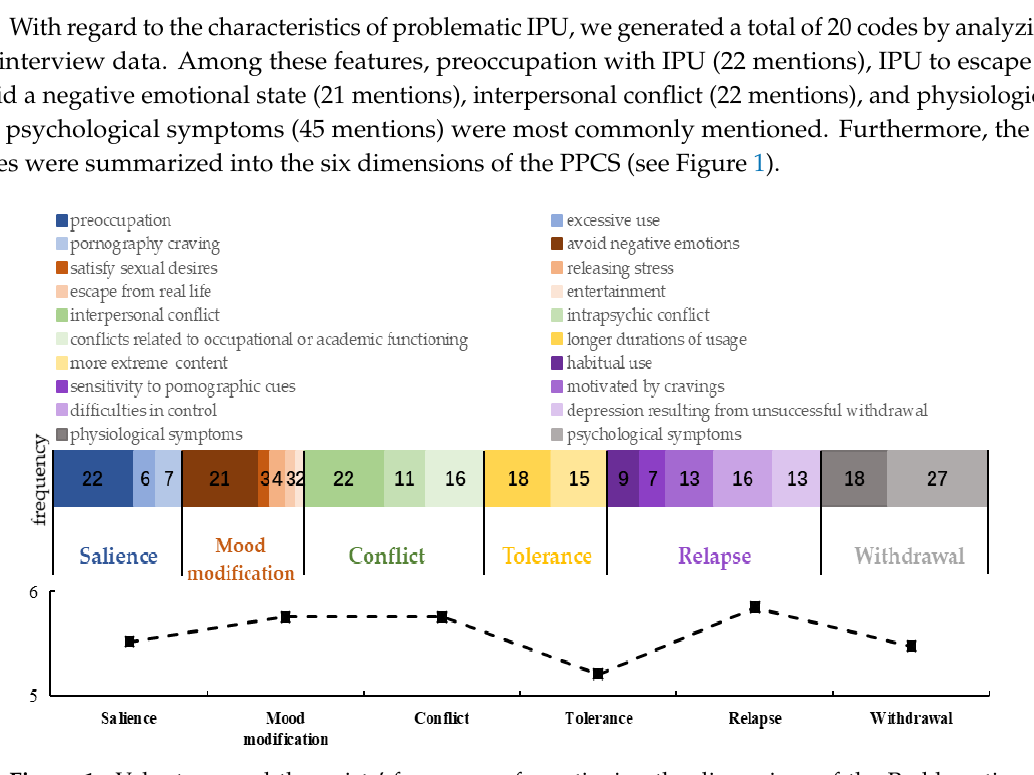
Figure 1. Volunteers and therapists’ frequency of mentioning the dimensions of the Problematic Pornography Consumption Scale, features, and importance ratings for the six dimensions (average scores across 33 interviewees). Note: the numbers in the color blocks represent the frequency of mentions, whereas the polyline represents importance ratings for the six dimensions (range = 1 – 7) .